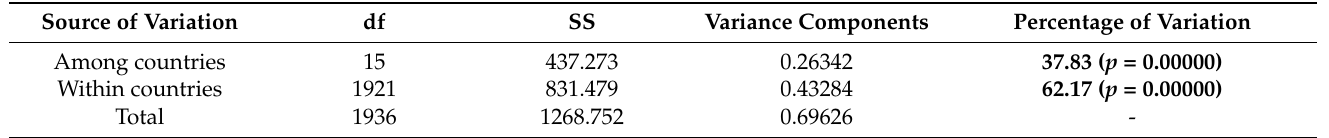
Table 3. Outcomes of AMOVA analysis based on the variability of the tRNA leu -cox2 intergenic region analyzed for 14 countries (Serbia*, Romania, Austria, Hungary, Croatia, Slovenia, Bulgaria, B&H, Albania, North Macedonia, Montenegro, Greece, Ukraine and Italy) and 8 localities from Serbia (L, V, S, T, S, Vr, DS and FG). Serbia*—population set represented by the literature and GenBank data for Serbia.